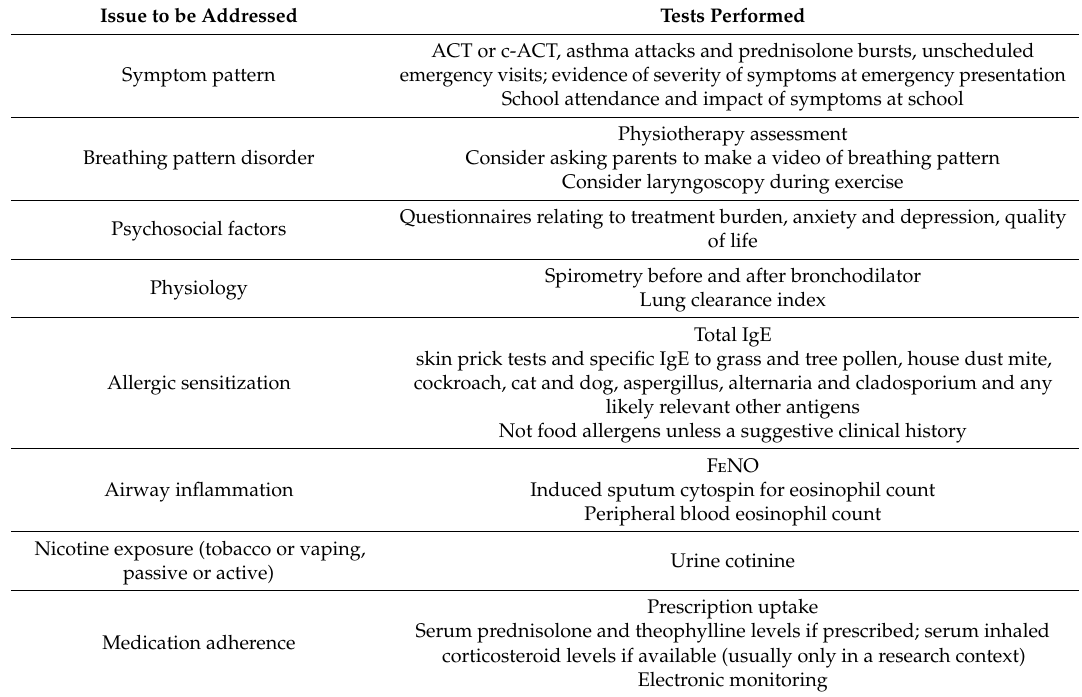
Table 2. Multidisciplinary assessment of severe, therapy-resistant